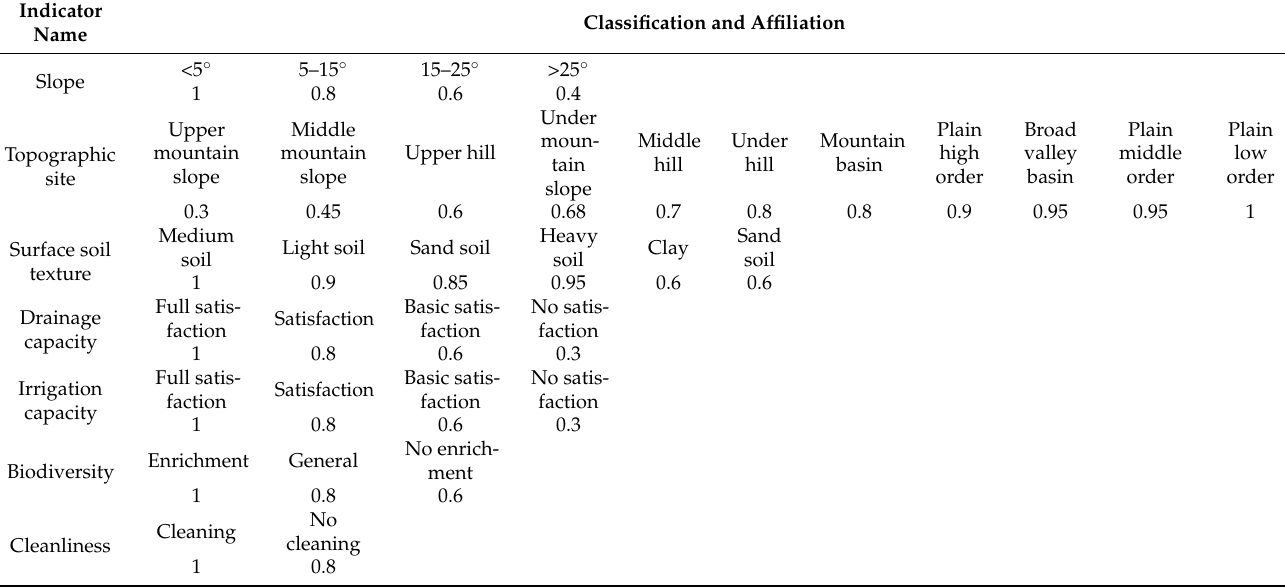
Table 2. Classification of qualitative indicators and their